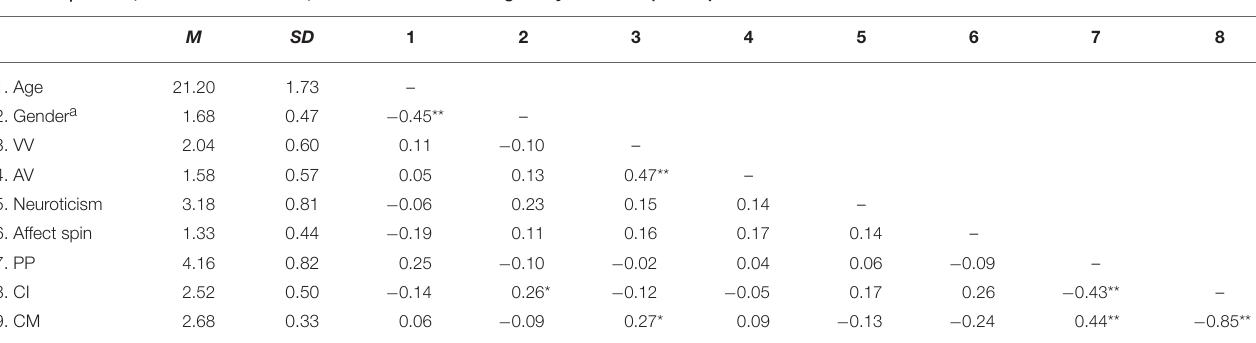
TABLE 1 | Means, standard deviations, and correlations among study variables ( N = 70 ).